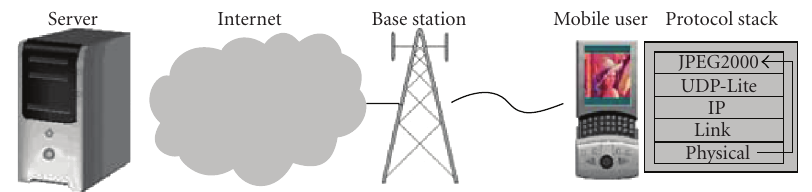
Figure 1: Considered